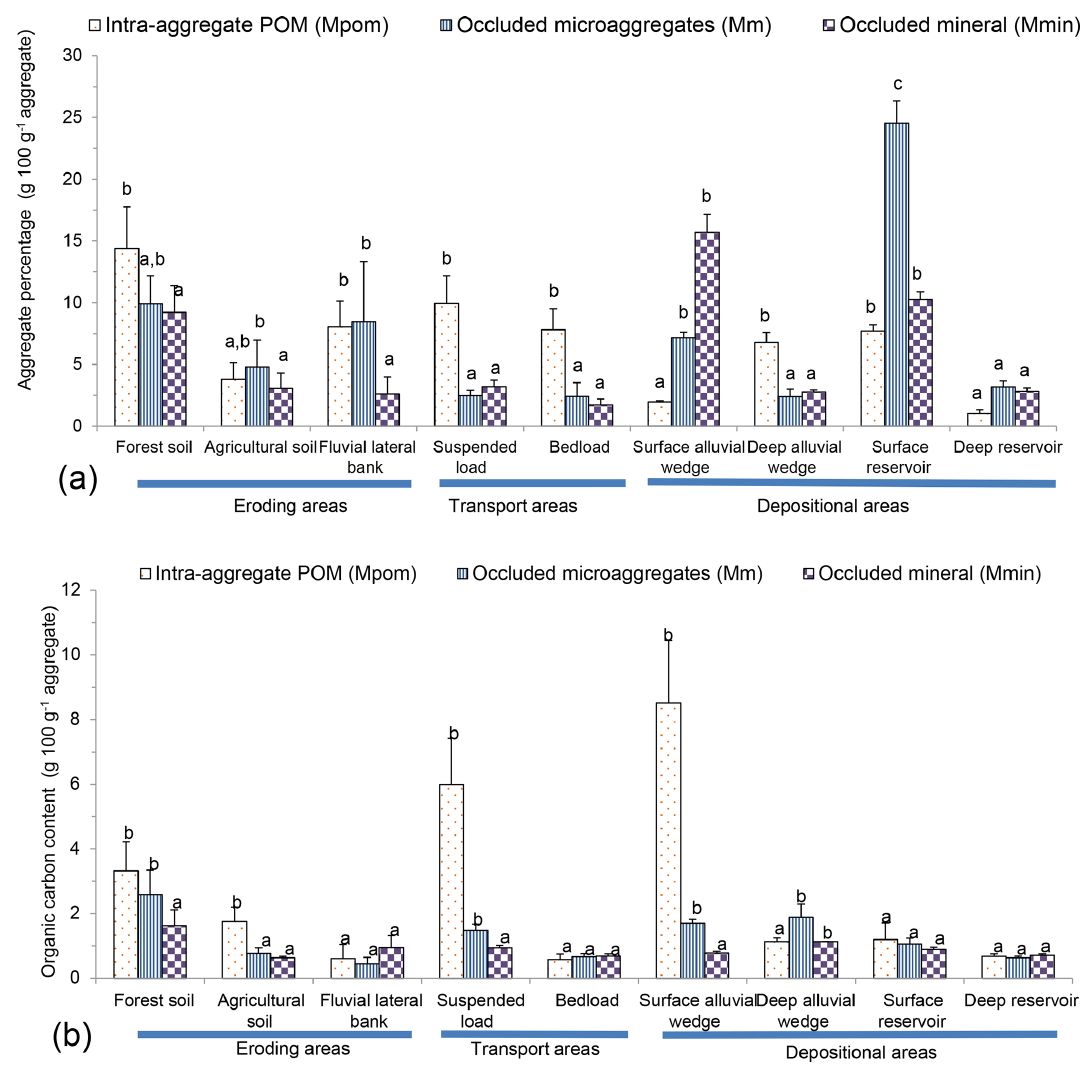
Figure 4. (a) Weight percentage (g 100g − 1 aggregate) of the fractions occluded within macroaggregates (M) for intra-aggregate particulate organic matter ( M pom ), occluded microaggregates (Mm), and occluded mineral fraction (Mmin) in different geomorphological positions within the catchment: eroding, transport, and depositional areas. Numeral values are means ± SE. Bars with different lowercase letters indicate significant differences in the percentage of each water-stable aggregate size among the different soils and sediments ( p< 0 . 05) according to the Kruskal–Wallis test. (b) Organic carbon content (g 100g − 1 aggregate) associated to the occluded fractions within total macroaggregates (%) for intra-aggregate particulate organic matter ( M pom ), occluded microaggregates (Mm), and occluded mineral fraction (Mmin) in different geomorphological positions within the catchment: eroding, transport, and depositional areas. Numeral values are means ± SE. Bars with different lowercase letters indicate significant differences in the percentage of each water-stable aggregate size among the different soils and sediments ( p< 0 . 05) according to the Kruskal–Wallis